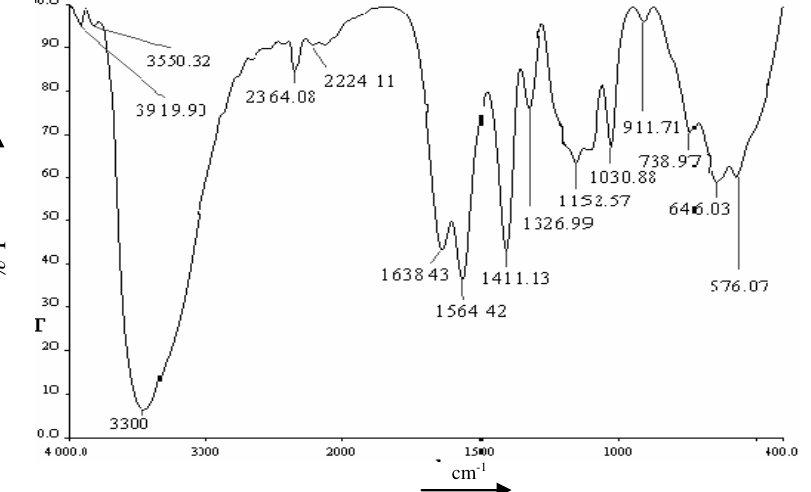
Figure 3. FTIR spectrum of 7-bromo-6-chloro-3-[3-[(2 R ,3 S )-3-hydroxy-2-piperidyl]-2- oxopropyl]-4(3 H )-quinazolinone crystal Table 1. Frequencies of the fundamental vibrations of